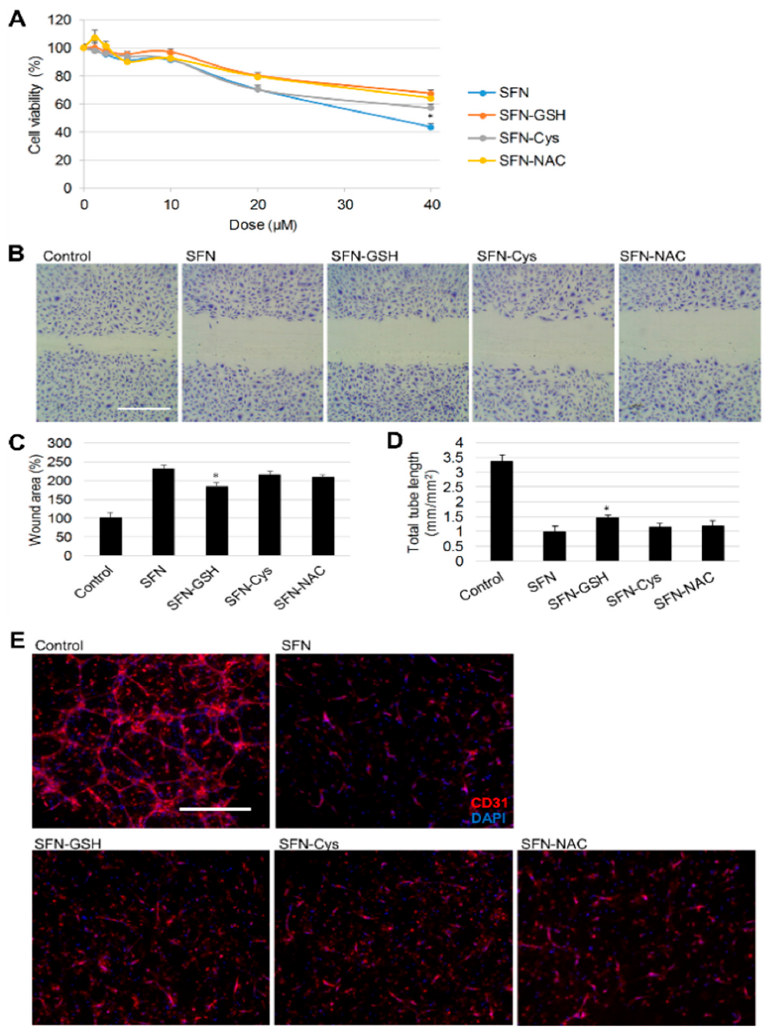
Figure 4. Effect of SFN and its metabolites on cell viability, migration and tube formation of human umbilical vein endothelial cells (HUVECs). ( A ) Cells were treated with different doses of SFN or its metabolites for 24 h, then cell viability was determined by MTT assay with DMSO (0.1%) as control. Results represent the mean ± SD ( n ≥ 5). Statistical significance within groups treated with the same dose, * p < 0.05. ( B ) Representative phase contrast images from the wound assay under 20 µM SFN or metabolites treatment for 12 h with DMSO (0.1%) as control, scale bar = 1 mm. ( C ) Wound areas are presented as mean ± SD ( n ≥ 5), * p < 0.05 compared to SFN treated group. ( D ) The total lengths of CD31 positive tubes formed in treated groups (10 µM SFN or its metabolites) with DMSO (0.1%) as control were measured and expressed as mean ± SD ( n ≥ 3), * p < 0.05 compared to the SFN treated group. ( E ) Representative merged pictures from 3D co-cultures with CD31 endothelial cell marker (red) and DAPI nuclei staining (blue). Scale bar = 500 µm.